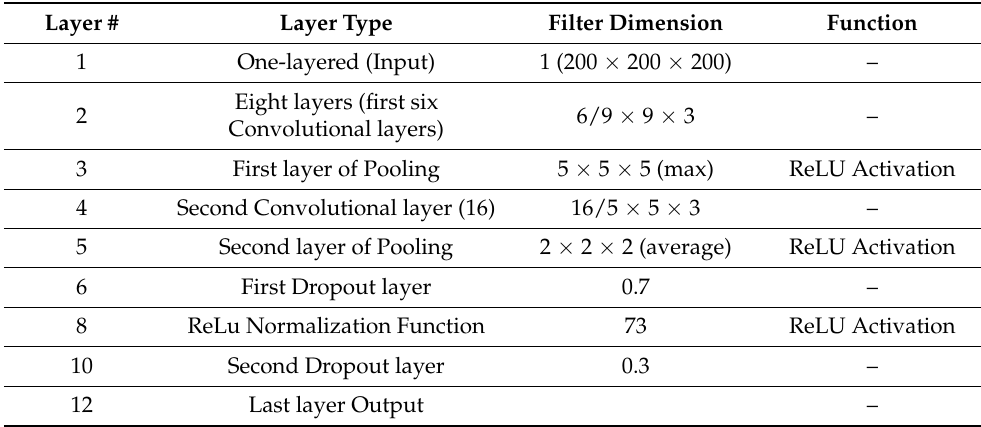
Table 2. The representation of the proposed